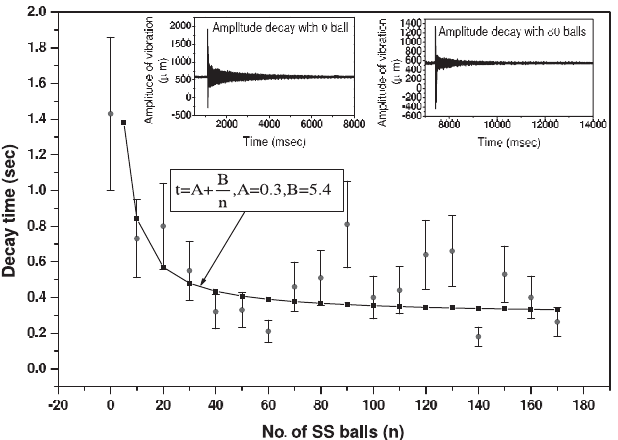
FIG. 4. Decay time of the displacement amplitude of the central conductor with the number of balls. The inside portion of the central conductor is in air. The resonator is at room temperature and atmospheric pressure. Two inset figures show how the vibration amplitude decays with time for 0 and 80 balls.